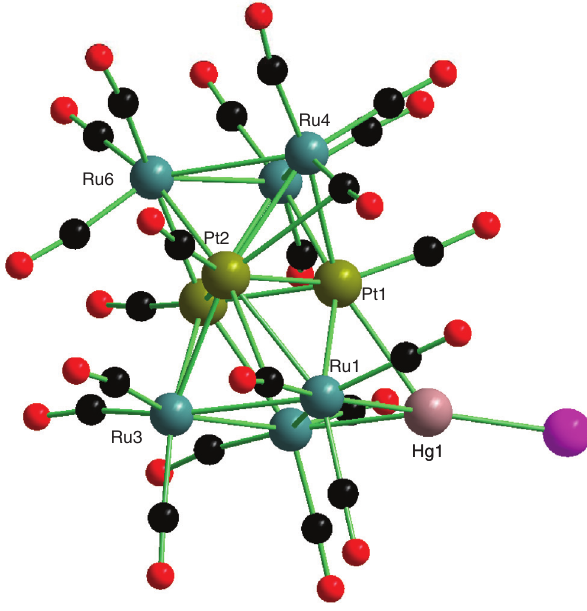
Figure 4 Simplified view of the molecular structure (diamond) of Figure 5 Simplified view of the molecular structure (diamond)